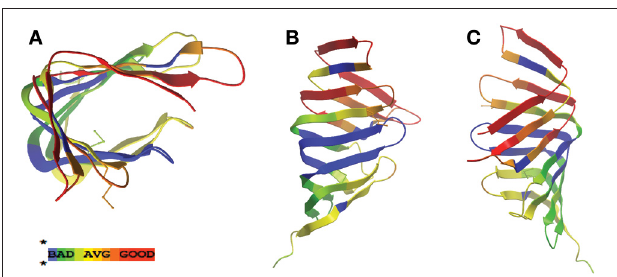
FIGURE 7 | LptC displays greatest structural homology at the N-terminal region. Ribbon structure of LptC protein from E. coli [PDB ID: 3MY2, (Tran et al., 2010)] with areas of similarity to the H. pylori homolog (HP1569) displayed in color code described previously in Figure 2 . Views presented are overhead (A) and side (B–C)